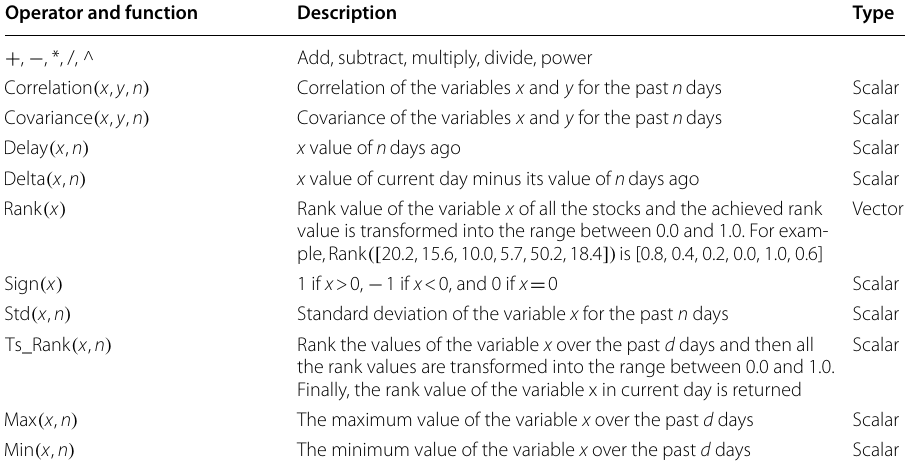
Table 14 Operators and functions in the formulaic